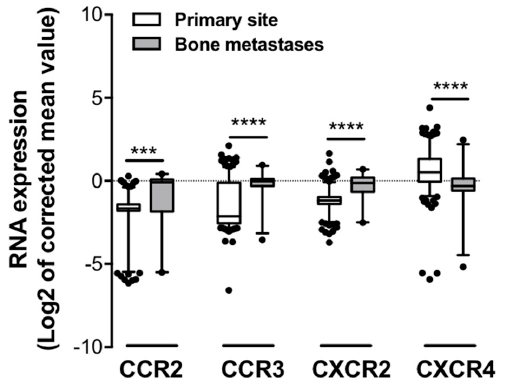
Figure 4. Expression of chemokine receptors in primary versus bone metastases of human PCa. The cancer microarray database, Oncomine was used to compare the RNA expression of several chemokine receptors (CCR2, CCR3, CXCR2 and CXCR4) in patient samples collected from bone metastatic (grey squares) or primary sites (white squares) from six different data-sets. Differences between the two independent groups were evaluated with Mann-Whitney’s test. *** p ≤ 0.001, **** p ≤ 0.0001. Secondly, to strengthen the clinical relevance of our results, we investigated CCR3 expression in different metastatic sites of PCa in two independent TMA. As shown in Figure 5, the number of CCR3 positive tumors was significantly higher in bone versus visceral metastasis, whereas no significant differences were observed between lymph nodes and bone sites. It is interesting to note that the majority of visceral metastases were negative for CCR3 expression. However, the fact that 50% of the bone metastasis do not express CCR3 suggest that other chemokine receptors might also be involved in this process.